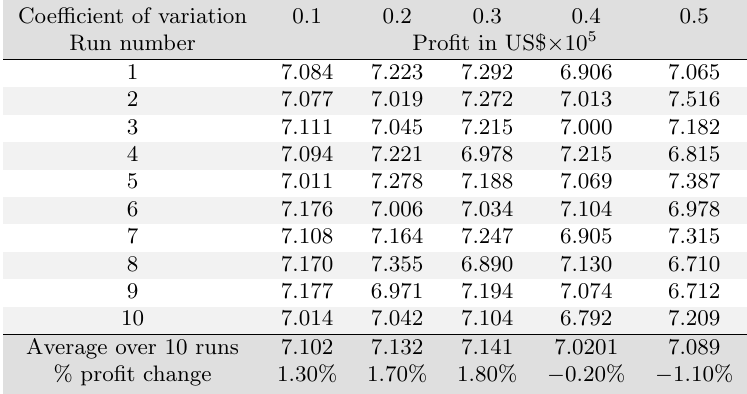
Table 7: Profit from random catch and variable trawler schedule for IFPMS. The results indicate three to four different types of trawler schedules for each